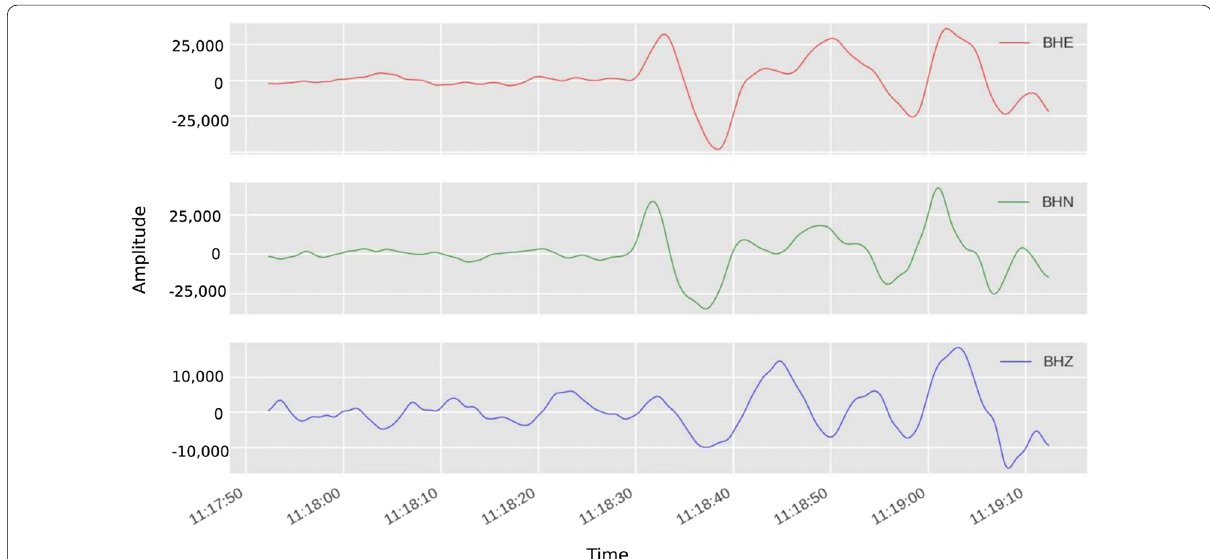
Fig. 7 Raw waveforms of unfiltered ZNE components for an event recorded at station ZF-MAYE (8/9/2009, 10:55:56.28, epicenter (33.1474, 138.0594), epicentral depth of 302.2 km, and M w = 7.1